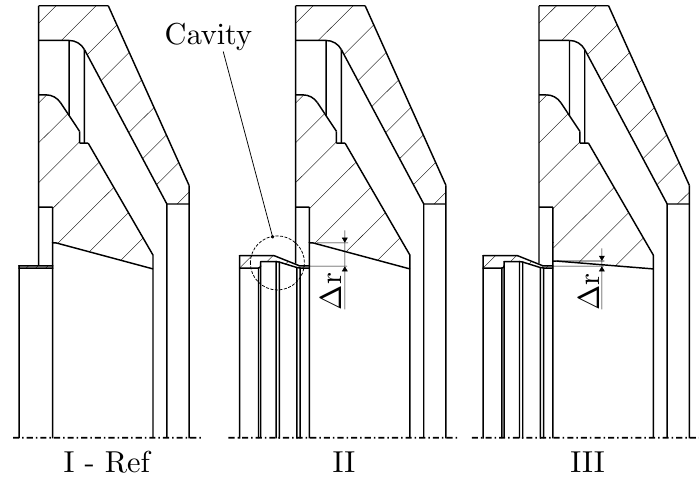
Figure 4. Fuel spray nozzle